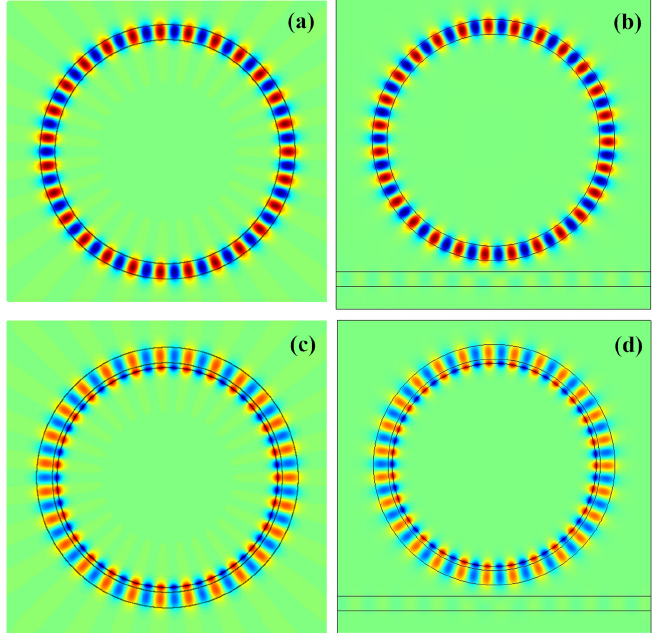
Figure 4. Electric field distribution of the WGM operating at mode 27. (a) The cross section of the waveguide; (b) the microring resonator; (c) the cross section of the waveguide loaded on NPM layer; (d) the microring resonator loaded on NPM layer. Thickness of the NPM layer is t = 0.09 μ